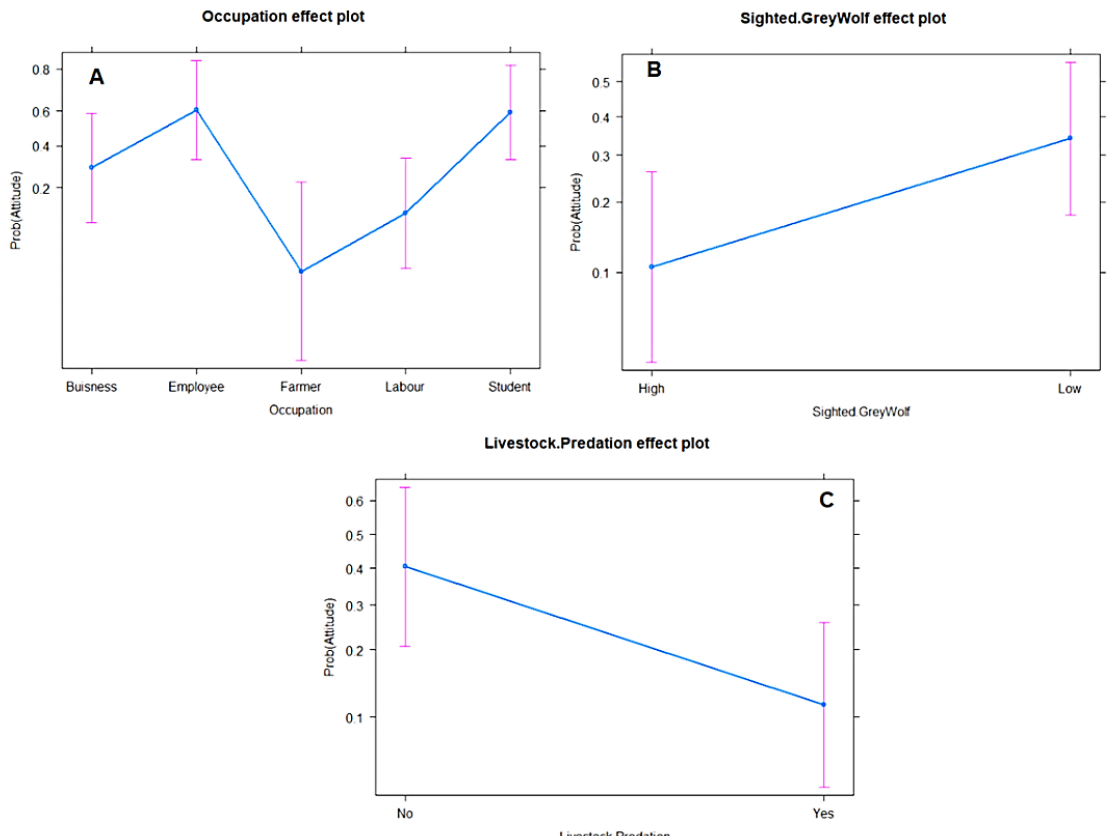
Figure 5. The number of appearances of the influential factors for each level over the chances of the respondents’ positive attitude towards the wolf. ( A ) Represents the occupations impacts ( B ) Represents sighted wolf impacts ( C ) Represents livestock predation impacts.